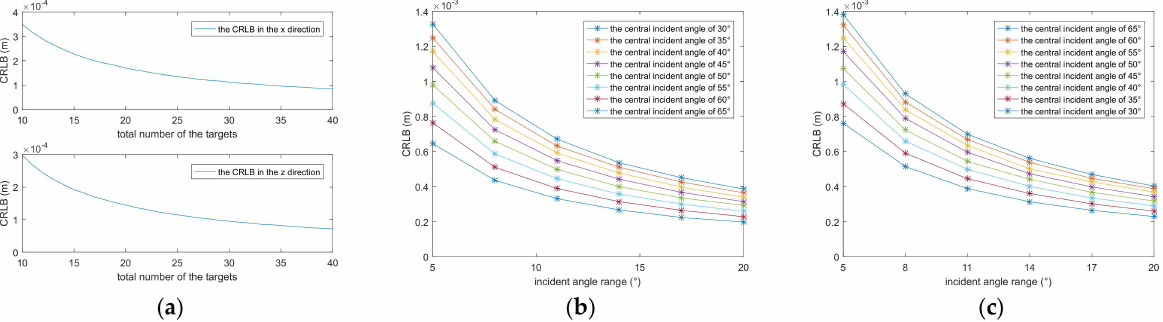
Figure 4. ( a ) The variation in the CRLB with the targets’ number; ( b ) The variation in the CRLB with the incident angle in the x direction; ( c ) The variation in the CRLB with the incident angle in the z